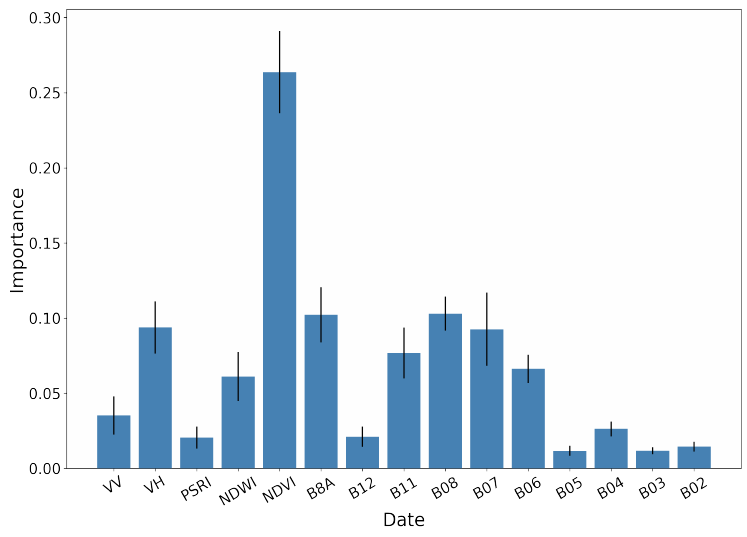
Figure 15. RF importances aggregated by feature type, along with the respective standard deviation for 10 different